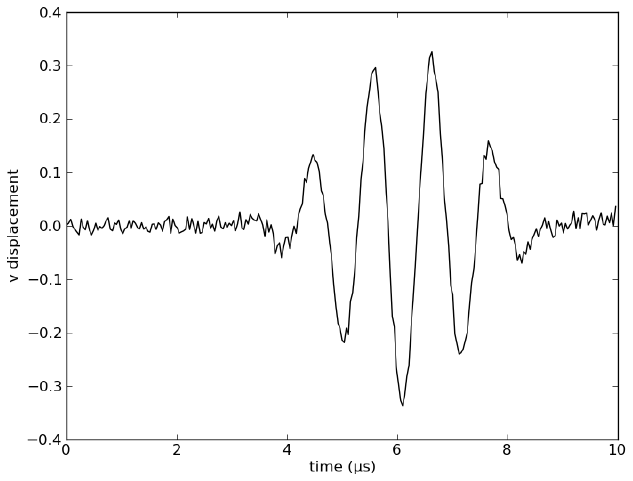
Fig. 9. Effect of adding 10% Gaussian noise for target signal for reconstruction by